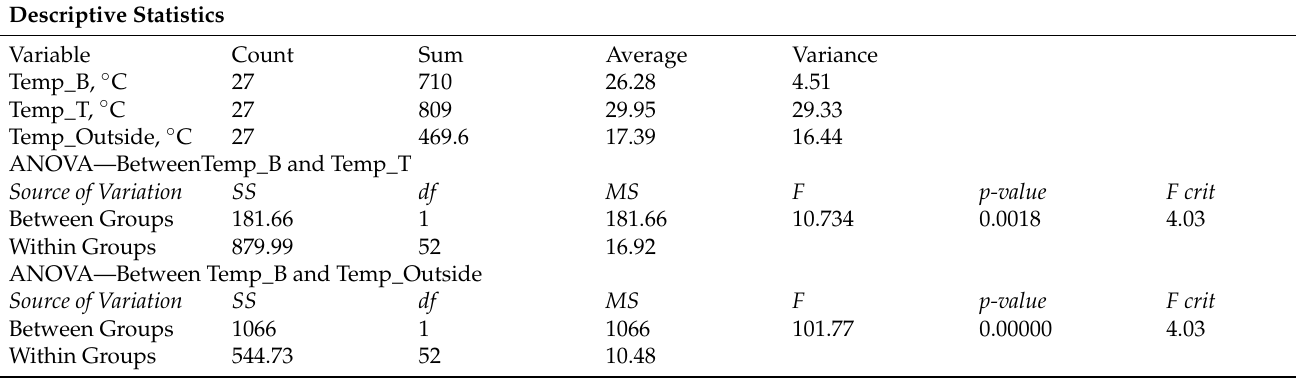
Table A2. Descriptive Statistics of Temperature Profile and ANOVA Test Statistics (Period 2).